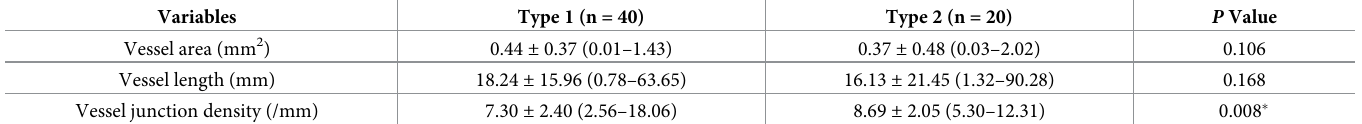
Table 2. Vessel area, vessel length, and vessel junction density on optical coherence tomography angiography in eyes with Type 1 and Type 2 choroidal neovascularization.